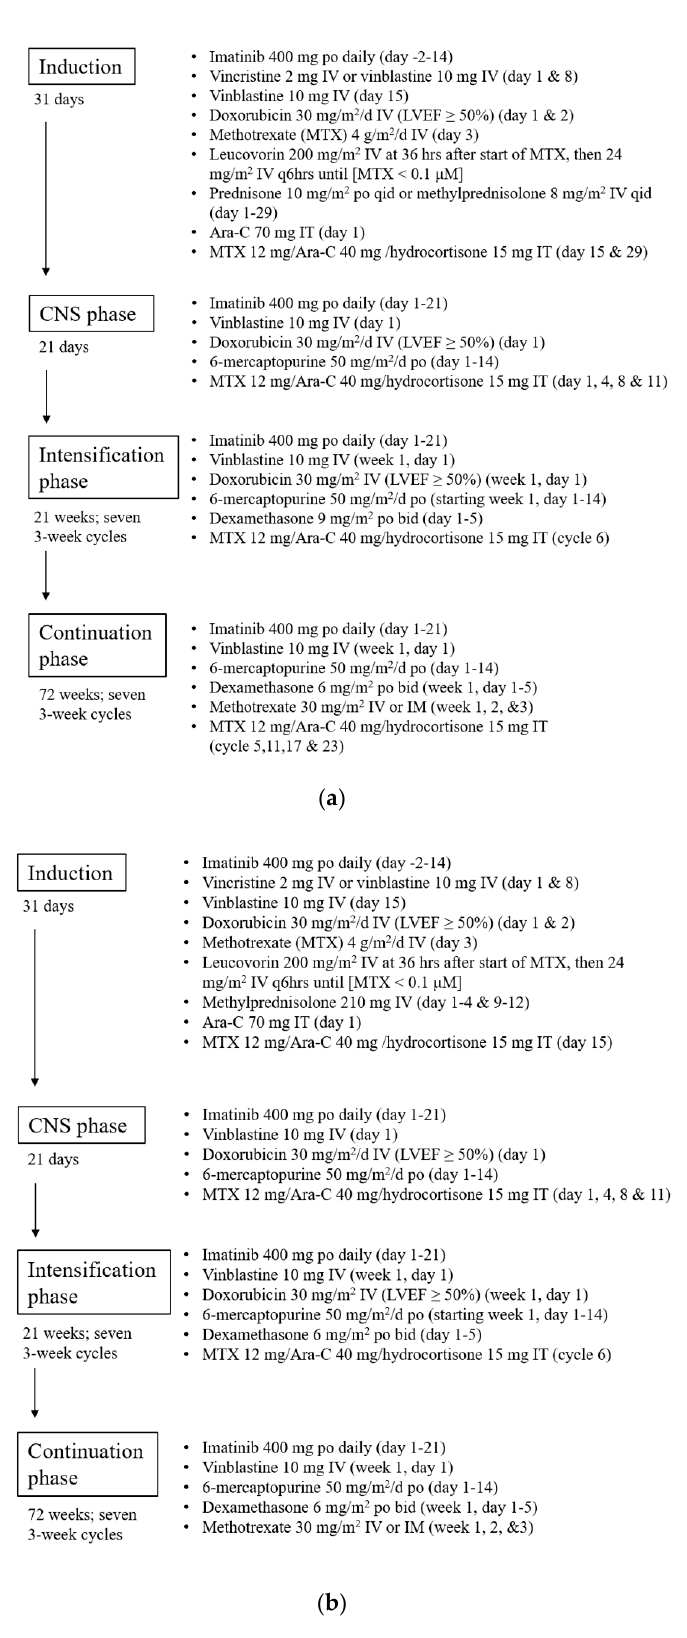
Figure 1. ( a ). Modified Dana Farber Cancer Institute (DFCI) protocol for adult Ph + ve acute lymphoblastic leukemia (ALL) patients with age under 60. ( b ). Modified DFCI protocol for adult Ph + ve ALL patients with age above